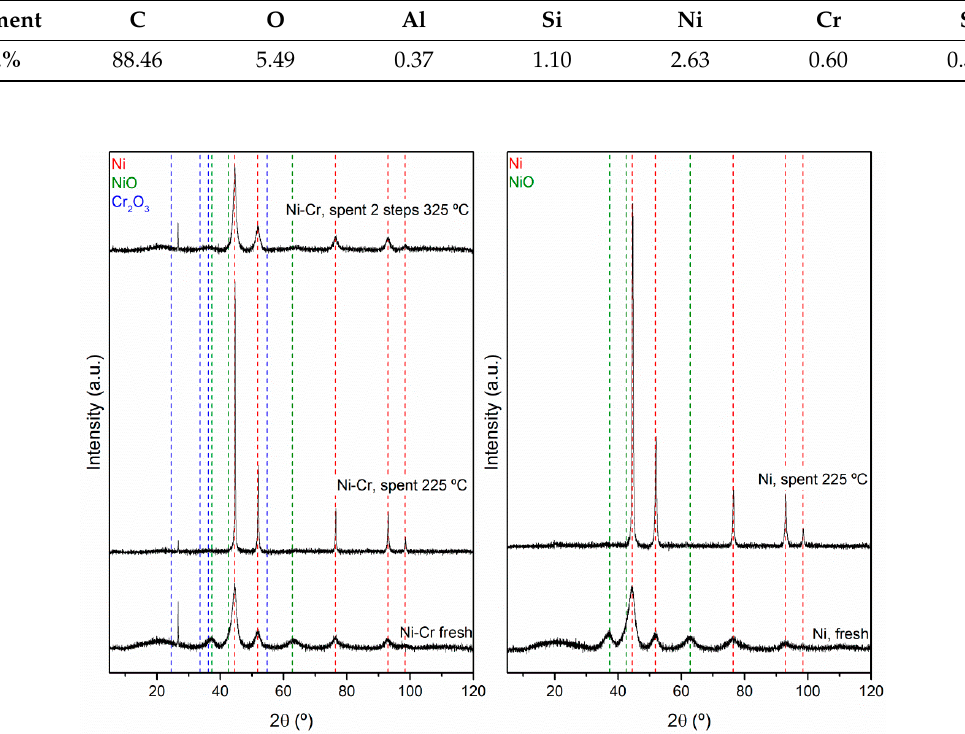
Figure 8. XRD powder di ff raction of fresh and spent Ni-based catalysts.